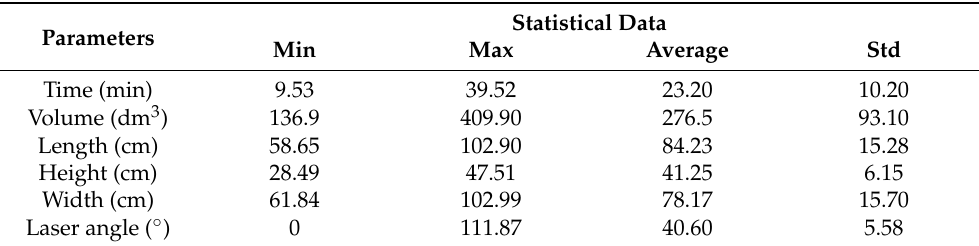
Table 1. Monitoring results of the vascular laser treatment. For each treatment session, the time of the procedure was measured. The length, height, width, volume, and laser angle (i.e., angle to the normal direction of the bed) were also computed from all of the treatment points of each monitored procedure. From this, the minimum, maximum, average, and standard deviation of the computed results are presented. Statistical Parameters